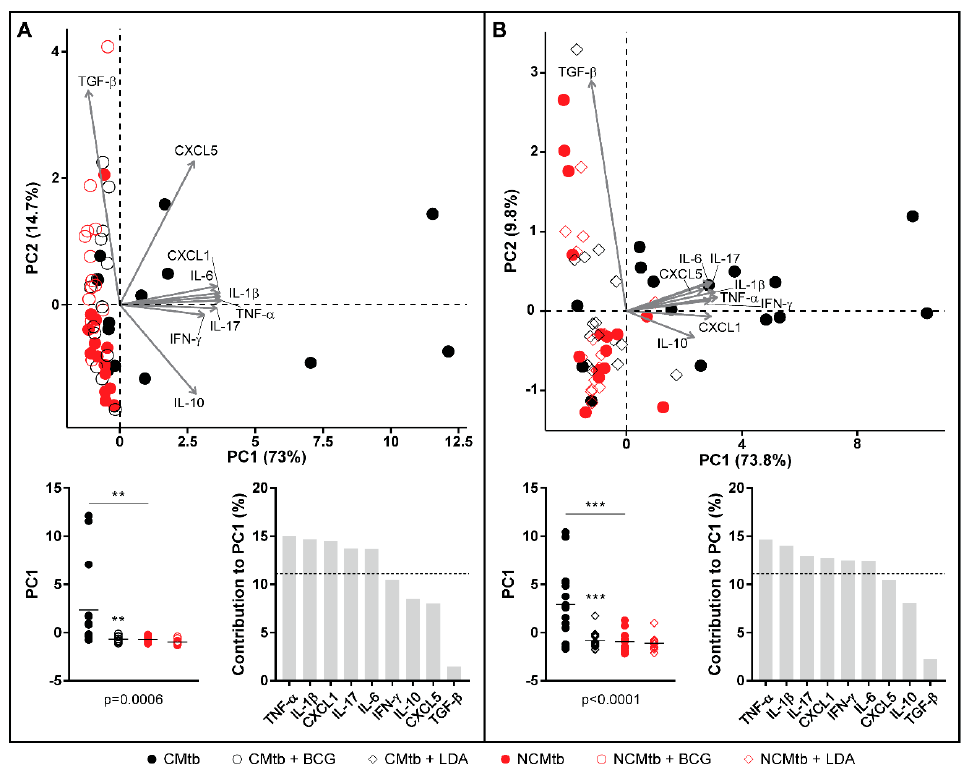
Figure 7. Comparison of PCA of inflammatory mediators after BCG vaccination ( A ) or LDA infection ( B ) in lung homogenates. PCA biplot showing each animal and variable (top). PC1 scores for each animal, lines are means; ANOVA and Sidak’s multiple comparisons test (** p < 0.01, *** p < 0.001) (bottom left). Mediators’ contribution to PC1 (bottom